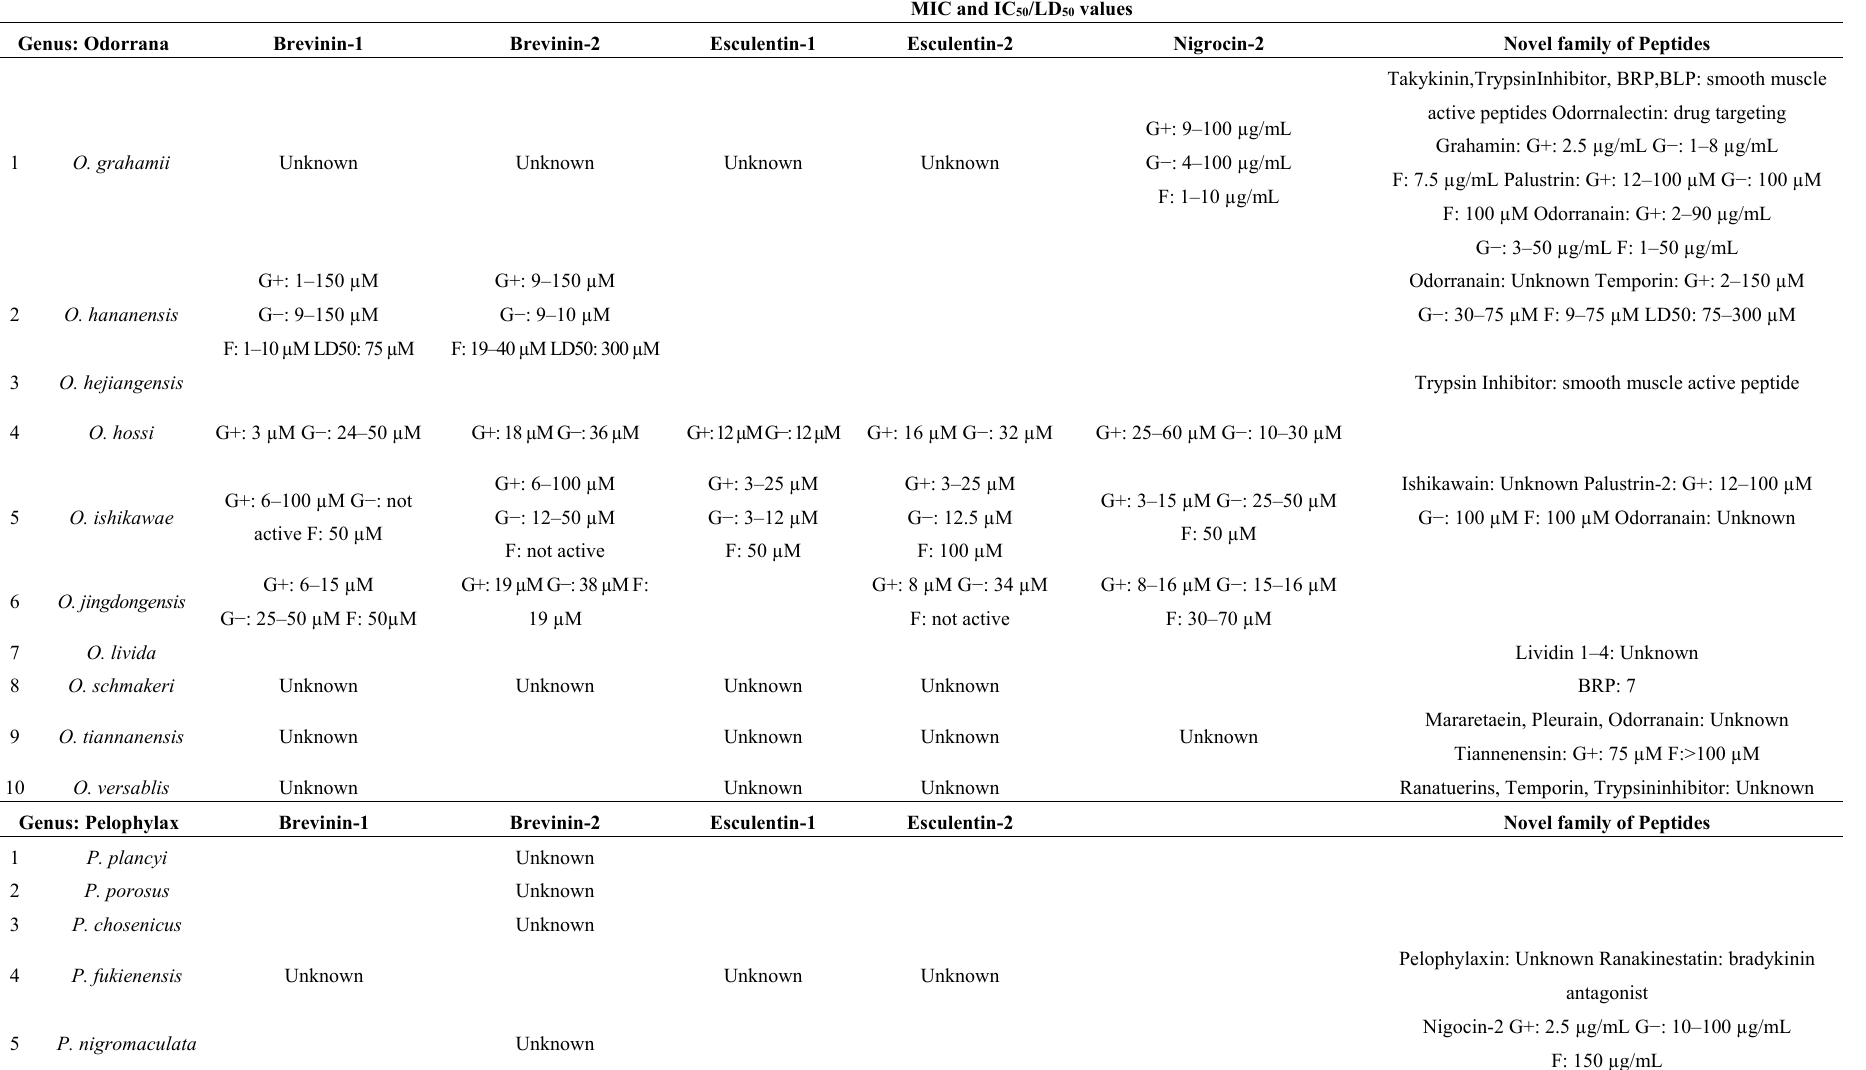
Table 2. Cont . MIC and IC 50 /LD 50